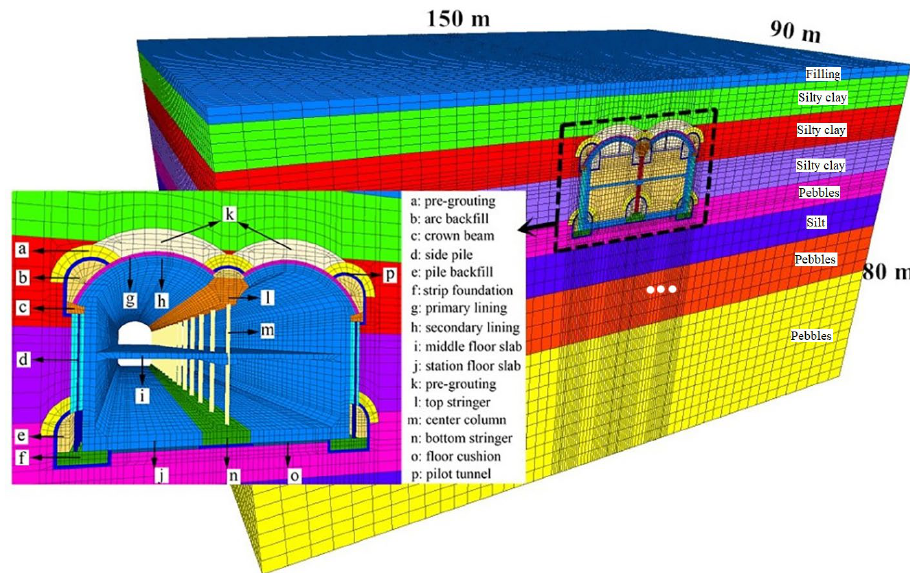
Figure 7. Structure and stratum numerical model of Qinghuadongluxikou Station.